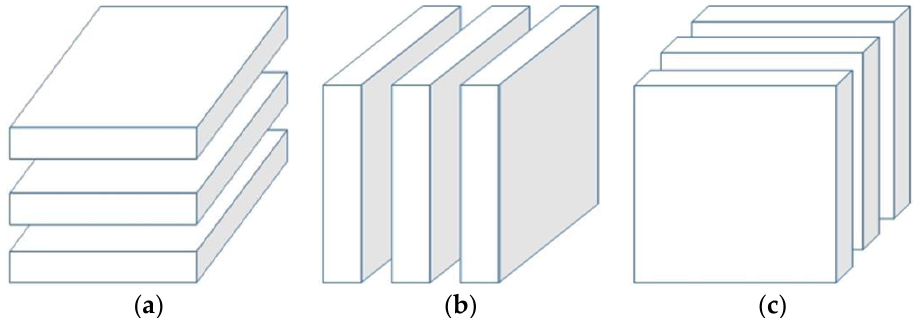
Figure 1. Slices of a third-order tensor. ( a ) horizontal slices, ( b ) lateral slices, ( c ) lateral slices.